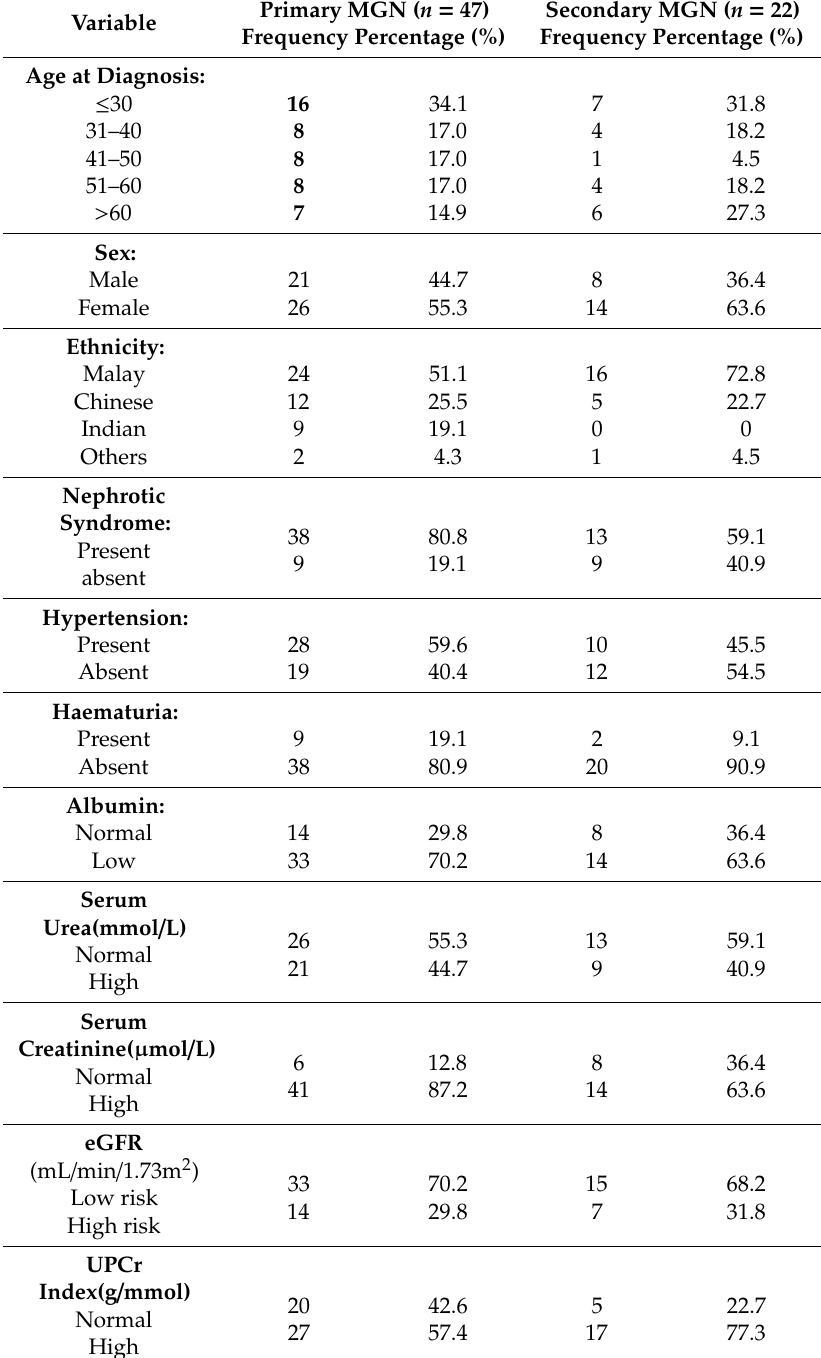
Table 1. Characteristics of subjects at the time of renal